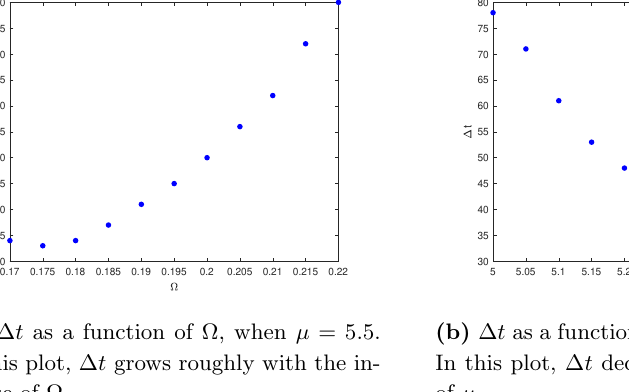
Figure 9. The period (cid:1) t between the appearance of the (cid:12)rst vortex and the point when dissipation reaches its maximum. Here we choose R =